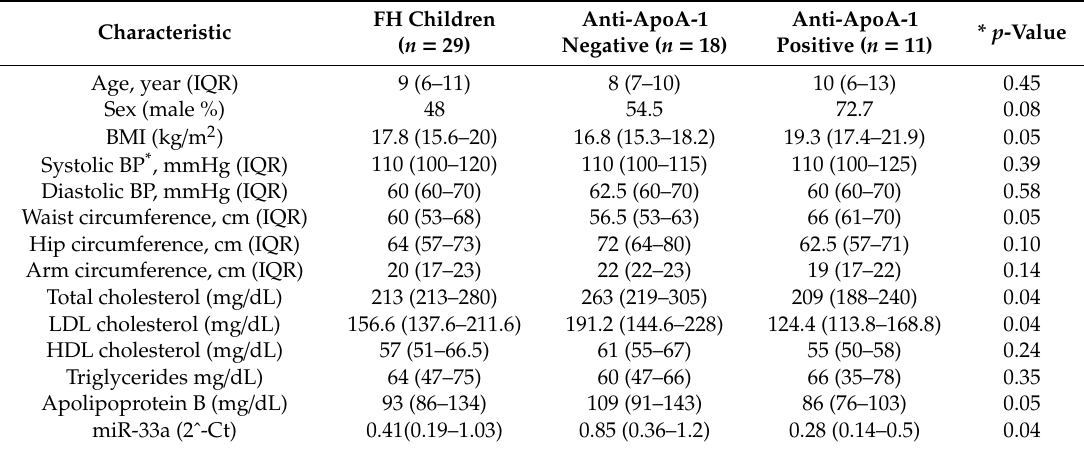
Table 3. Baseline demographic and biological characteristics of healthy children according to anti-ApoA-1 IgG